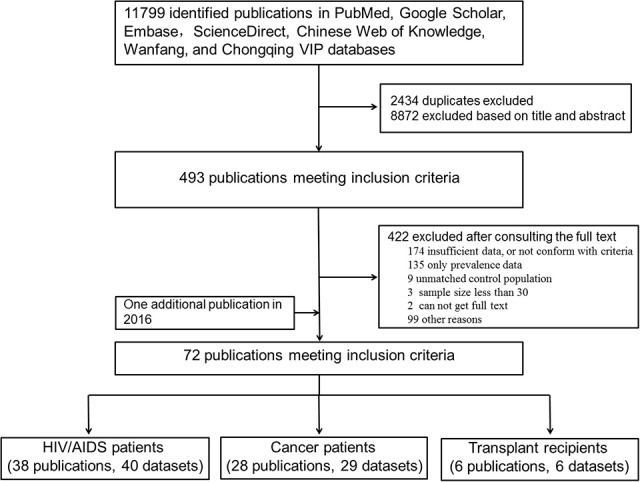
Data search and selection.